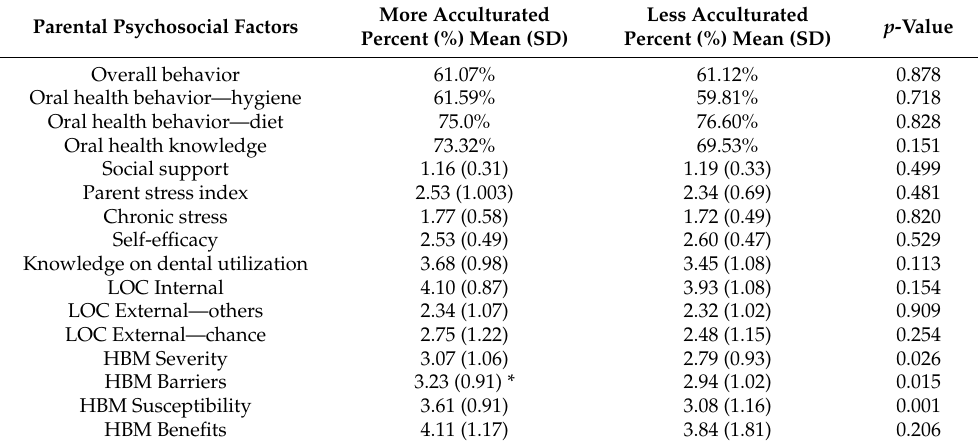
Table 1. Difference in means of less and more acculturated parental psychosocial factors. (Cut-off = 3.8). Parental Psychosocial